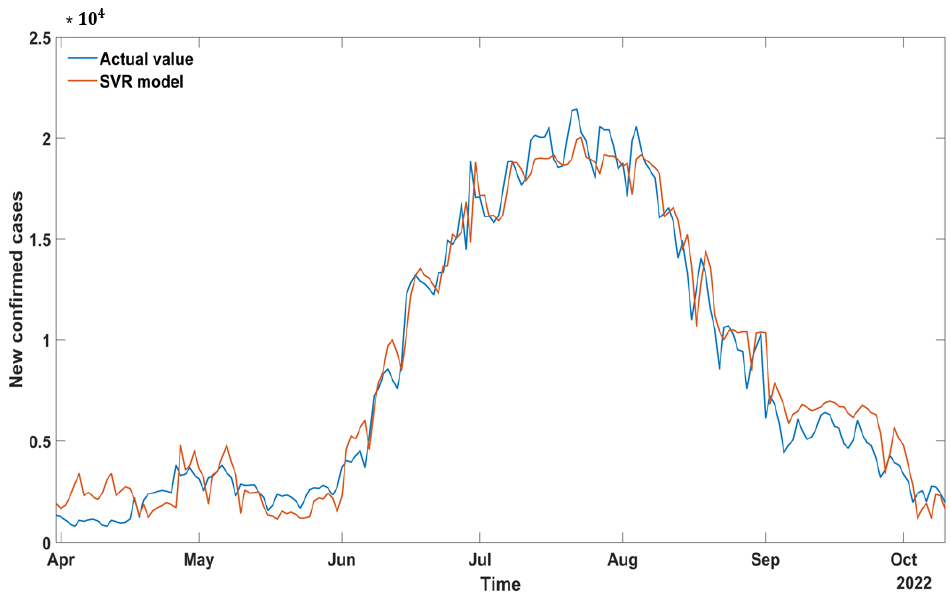
Figure 7. Comparison of the SVR model, combined model 2, and the true value.